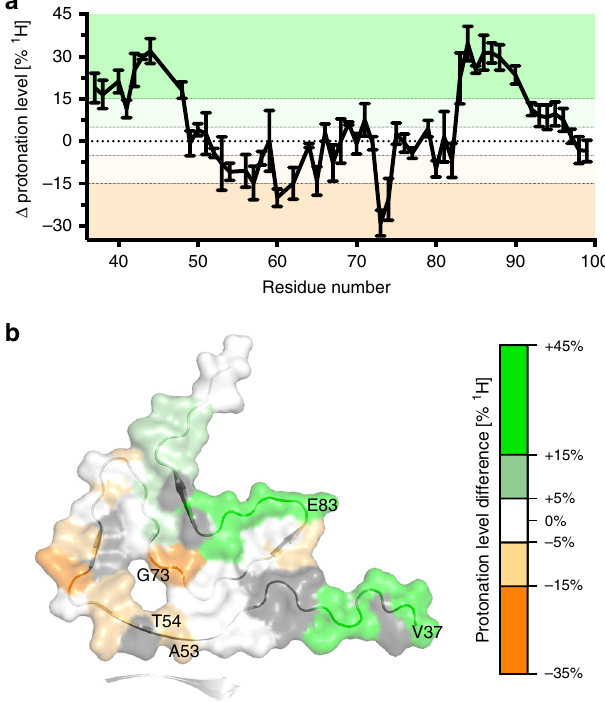
Fig. 6 Structural diversity in aSyn aggregates ampli fi ed from patient brain extracts. a , b Differences between protonation levels in aSyn fi brils ampli fi ed from PD1/PD2- and MSA1/2-brain extracts, mapped in ( b ) on the core structure of hsAsyn fi brils. Difference values were calculated on the basis of the average protonation levels observed for PD1 and PD2 (and MSA1 and MSA2, respectively). Errors were calculated from the differences in protonation levels between the two patient pro fi les of either PD or MSA. Residues that experience faster solvent exchange in MSA1/2 fi brils (when compared to PD1/PD2 fi brils) are shown in orange, those with slower solvent exchange in green. Residues with signal overlap were excluded from the analysis (shown in gray in ( b